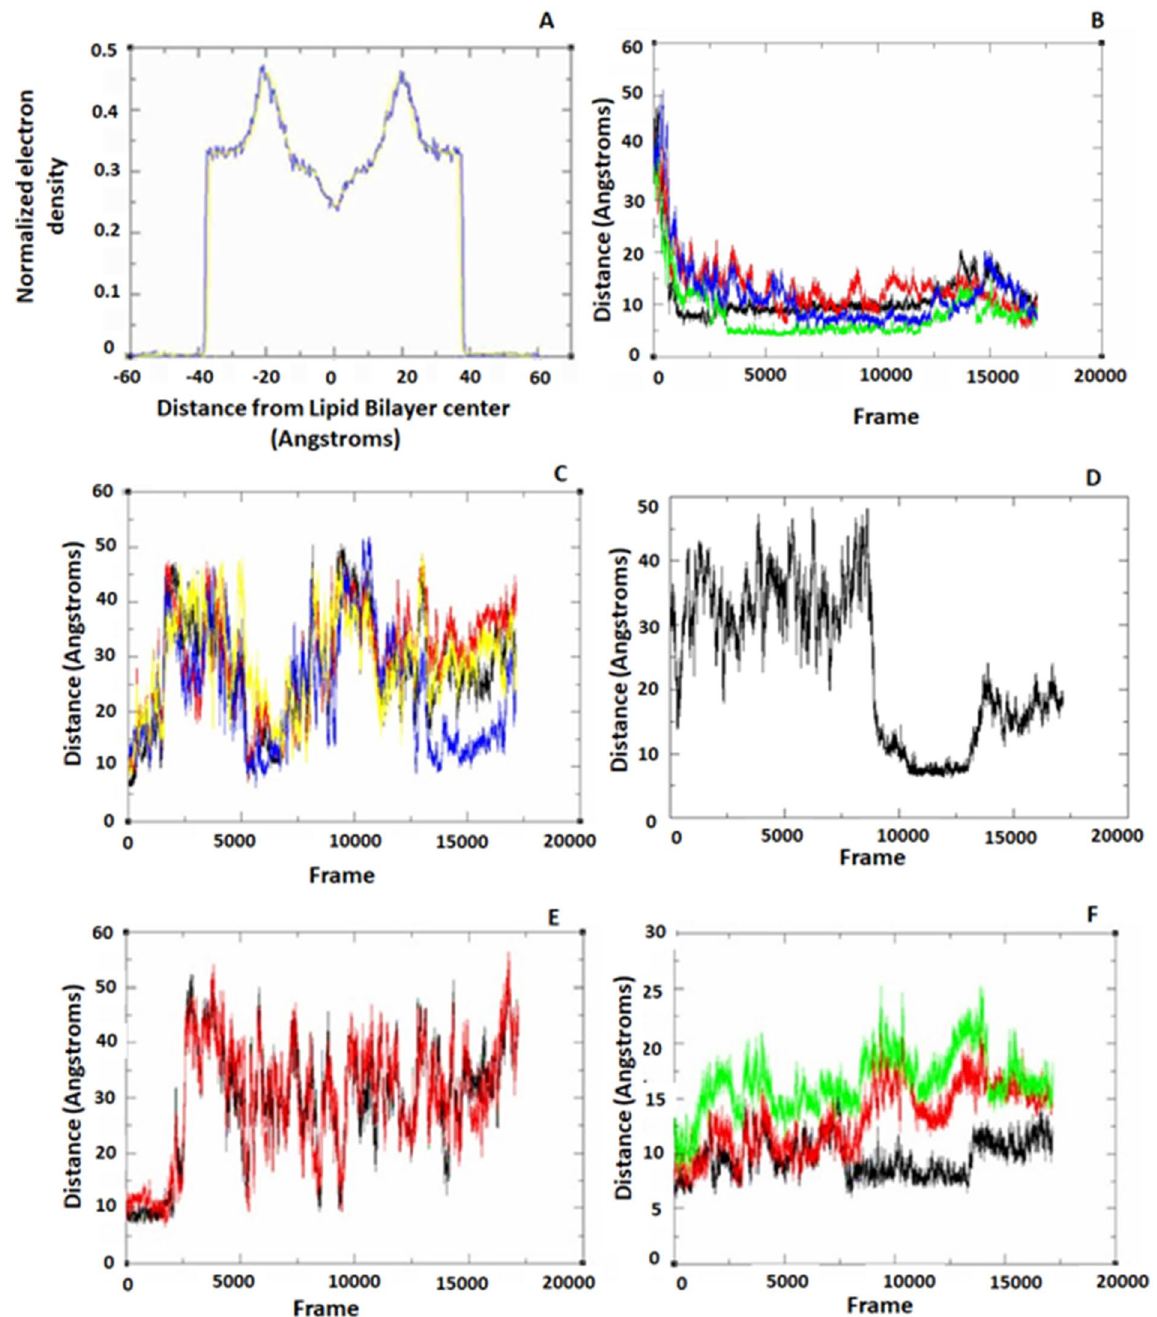
Figure 5. Electron density profile bilayer membranes and distances between the centre of mass of UDCA and PE. ( A ) Electron density profile bilayer membranes was very similar in all membranes along the trajectory, showing stable Molecular Dynamics. The virion membrane has a major percentage of DOPE and DOPS. The electron density remains stable on both leaves of the membrane (± 20 Angstroms). ( B ) Distances from the centre of mass of UDCA in relation to four centres of mass of PE, PE272 (black), PE218 (red), PE251 (green) and PC221 (blue), to which the UDCA molecules were attracted. We observed that in the virus membrane, once the UDCA residue is attracted, it tends to remain attached to the membrane. Distances calculated with CPPTRAJ. Also, in the Golgi intermediate compartment membrane (ERGIC), we have shown the distances from the centre of mass of UDCA residues to the phospholipid residues, for which it exhibits affinity. ( C ) It is observed that residue 401 of UDCA is close to the phospholipids PE17(black), PE20 (red), PC59 (blue) and PC47 (yellow). ( D ) The distance of residue UDCA 403 towards PE293 (black line) is observed. Both figures show affinity, however, they do not remain together over time . In addition, we evaluate the distances between the UDCA residues and PC, PE and CHL phospholipids. ( E ) We observed the distances between UDCA and PE. It is noteworthy that the only way that UDCA was attached to cholesterol was because 3 cholesterol residues were found together, if they were separate, UDCA and cholesterol tended to separate. ( F ) The distances between residues of UDCA and cholesterol are shown, we observed that from the beginning the UDCA and PE/CHL were united but over time they tended to